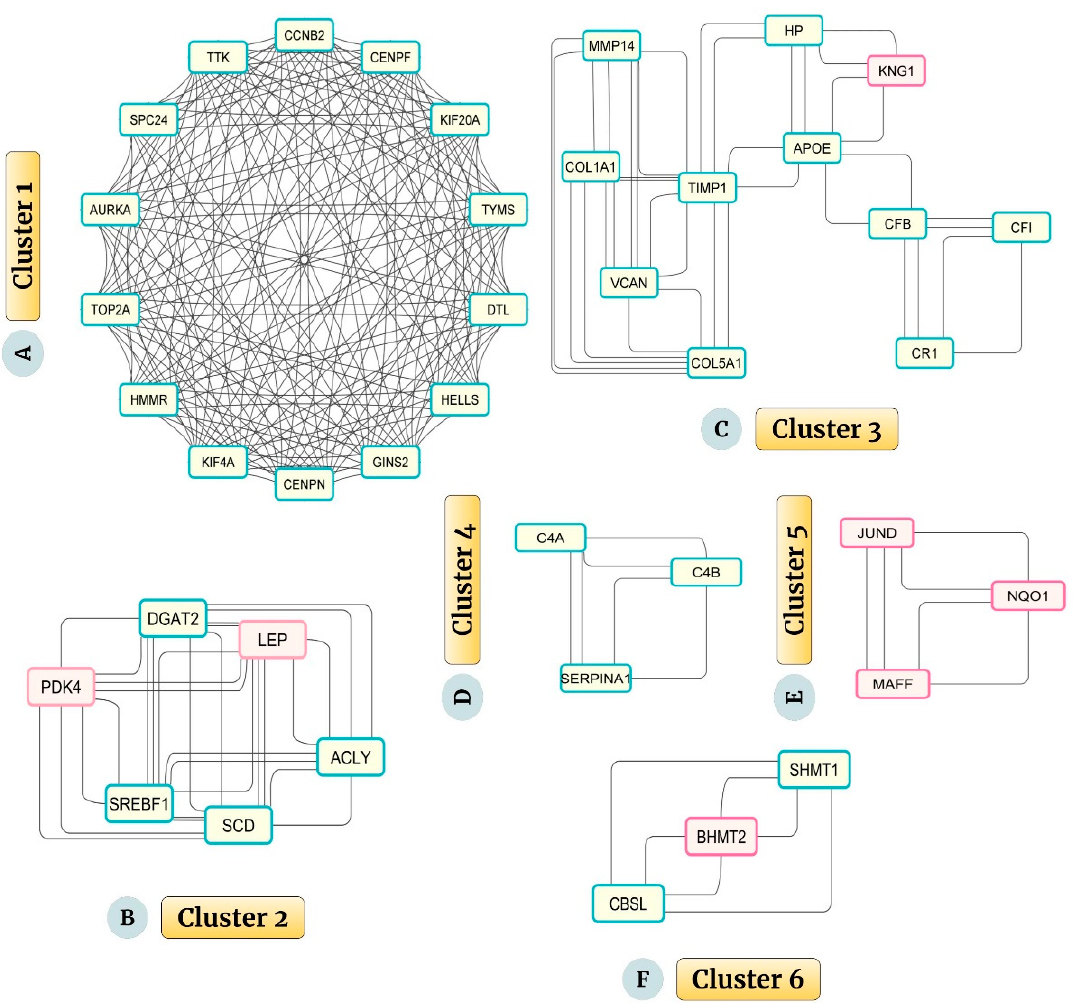
Figure 5. ( A – F ) The top six significant clusters were extracted from the PPI network through the MCODE plug-in. The red-purple border indicates the upregulated genes, and the green wall shows the downregulated overlapping genes. ( A ) Cluster 1 (KIF20A, AURKA, HMMR, TTK, TOP2A,